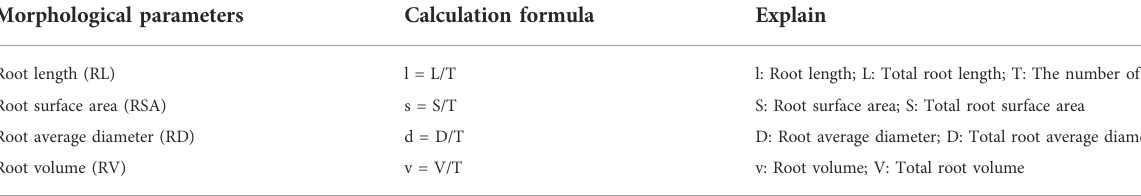
TABLE 2 Summary of calculation formulas for root morphological parameters. Morphological parameters Calculation formula